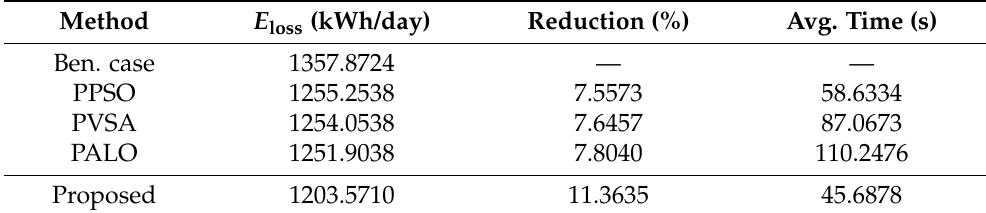
Table 5. Comparison of the proposed recursive convex approximation with combinatorial optimiza- tion methods considering MPPT in PV